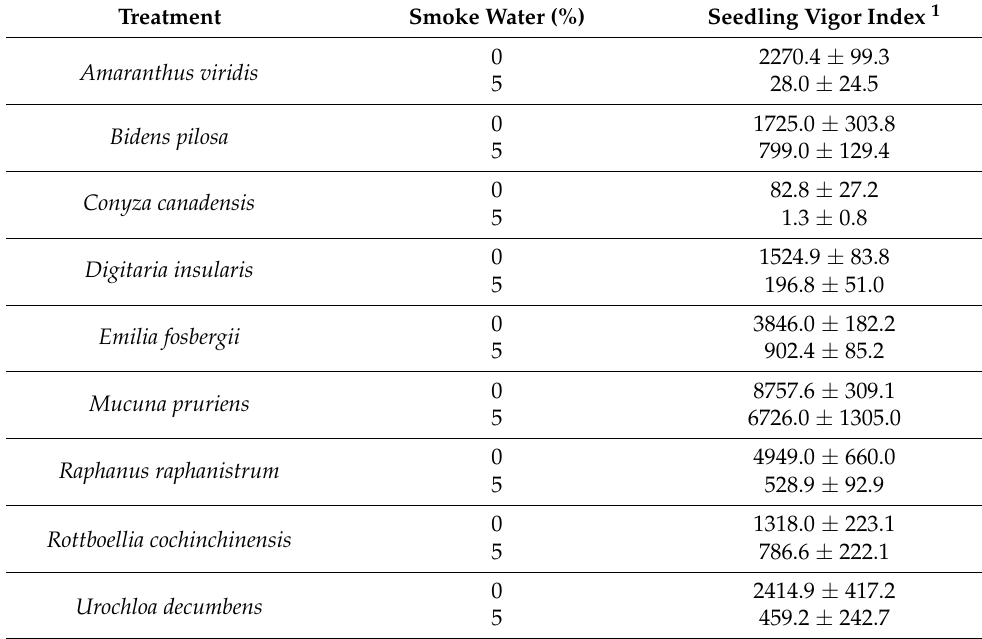
Table 6. Effect of smoke solutions on seedling vigor index of weeds under a 12 h photoperiod at 25 ◦